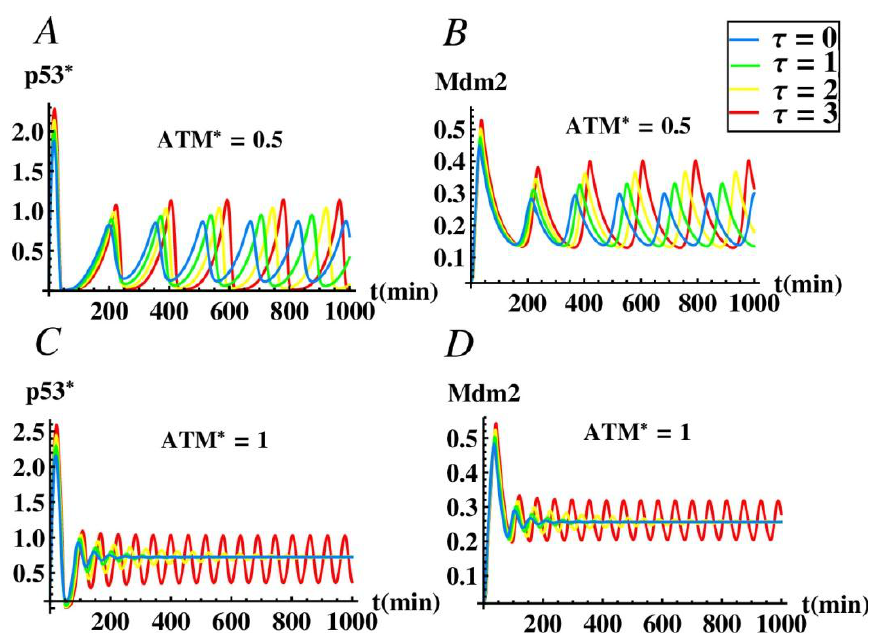
Figure 7. The effect of time delay on the dynamics of the p53-mdm2 system. ( A ) The time evolution process of the p53* concentration when ATM* = 0.5. ( B ) The time evolution process of the Mdm2 concentration when ATM* = 0.5. ( C ) The time evolution process of the p53* concentration when ATM* = 1. ( D ) The time evolution process of the Mdm2 concentration when ATM* = 1.